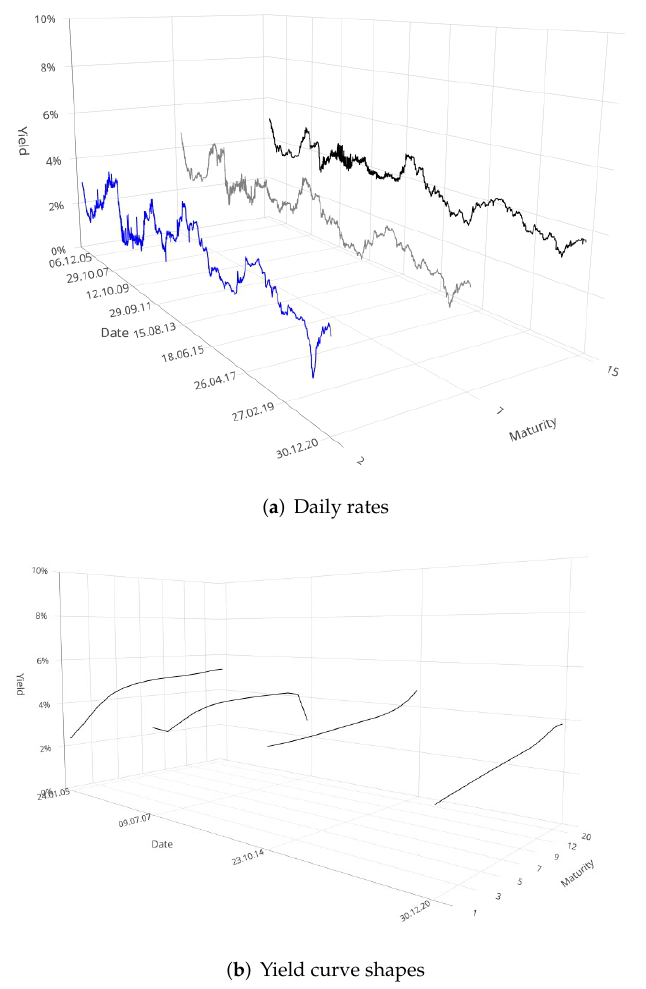
Figure 2. Behaviour of the daily rates for maturities 2, 7 and 15 years for China in the period 24/01/2005–30/12/2020 ( a ), and yield curve shapes for China ( b ) observed in t = 24/01/2005; 09/07/2007; 23/10/2014 and 30/12/2020,